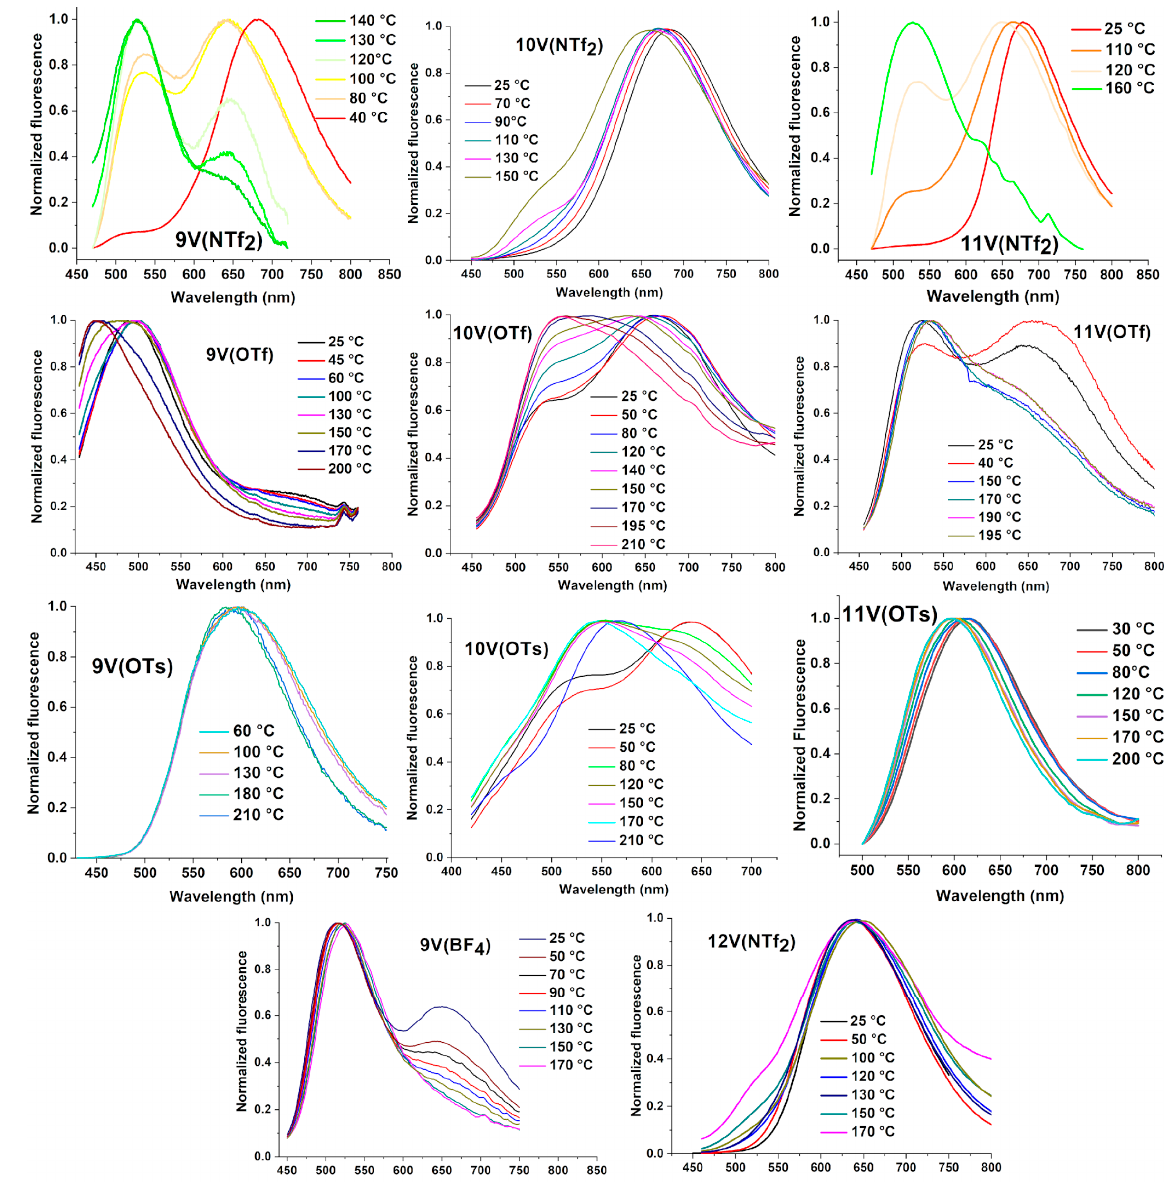
Figure 2. Normalized emission spectra of some thienoviologens recorded at different temperatures in the whole thermotropic range.